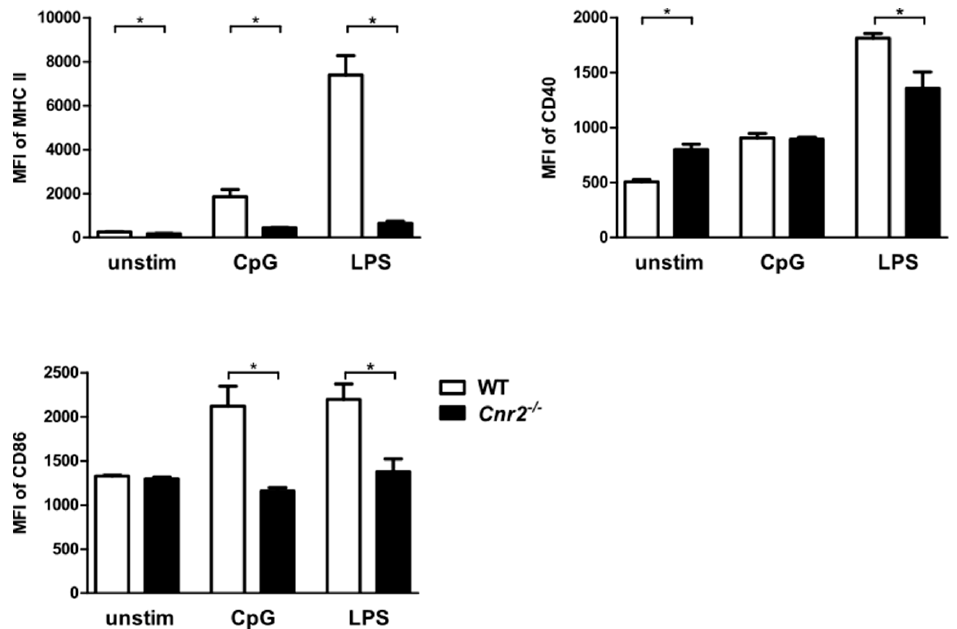
Figure 4. Reduced surface expression of MHC II and co-stimulatory molecules by Cnr2 − / − BM-DCs after Toll-like receptor (TLR) stimulation. Surface expression of MHC II, CD40, and CD86 by WT (white bars) or Cnr2 − / − (black bars) BM-DCs cultured for 16 h in the absence (unstim) or presence of 1 nmol / mL CpG or 100 ng / mL LPS. Data show median fluorescence intensity (MFI) ± SEM ( n = 4–5 animals / group). * p < 0.05.